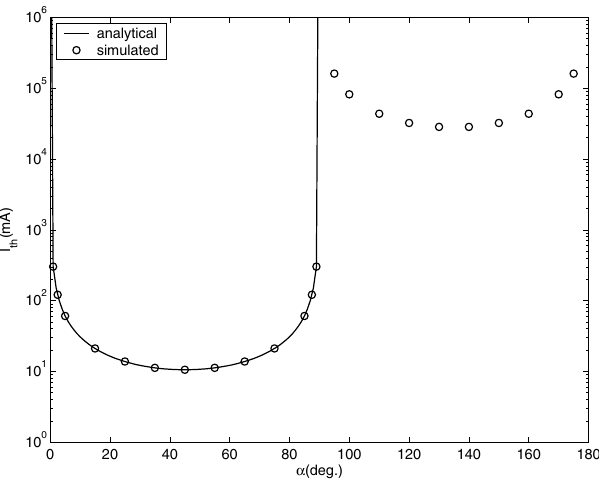
FIG. 2. BBU threshold for the reflecting matrix (30), calcu- lated from (15) and simulated by the new code, vs HOM rotation